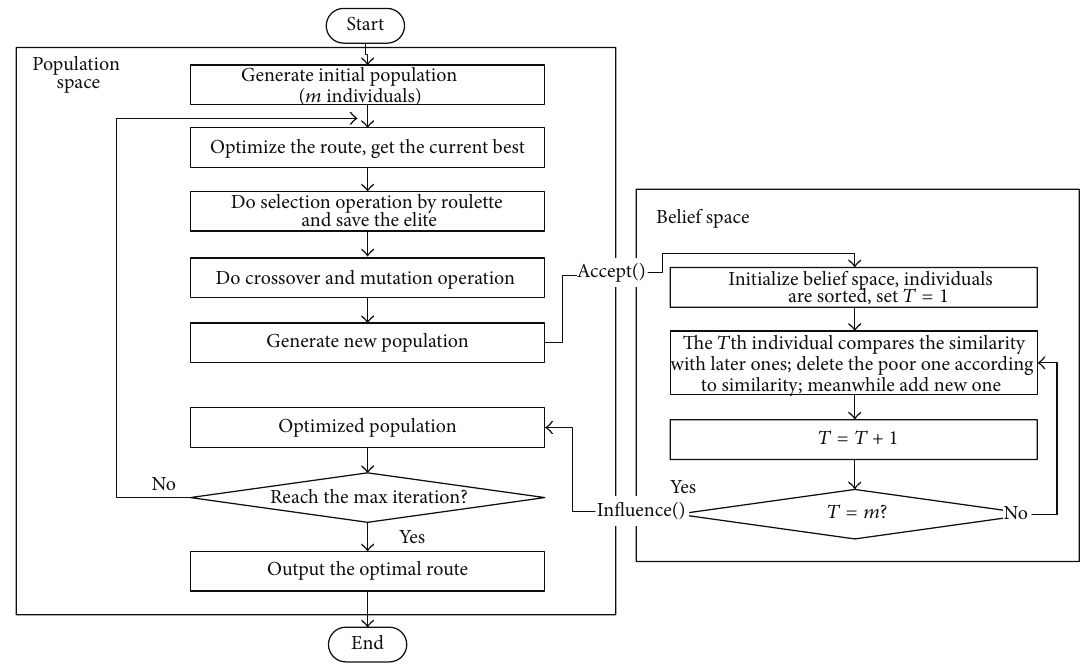
Figure 11: Flow chart of evolutionary genetic algorithm.